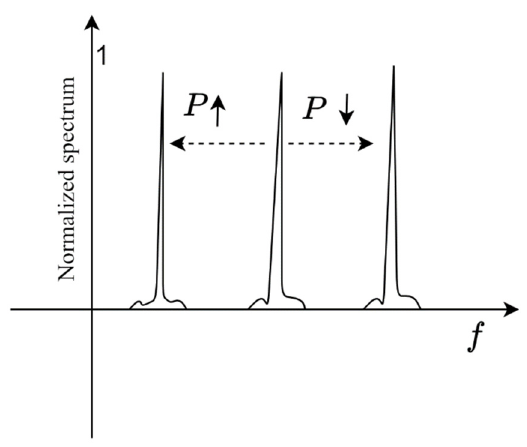
Figure 2. The relationship between switching frequency and output